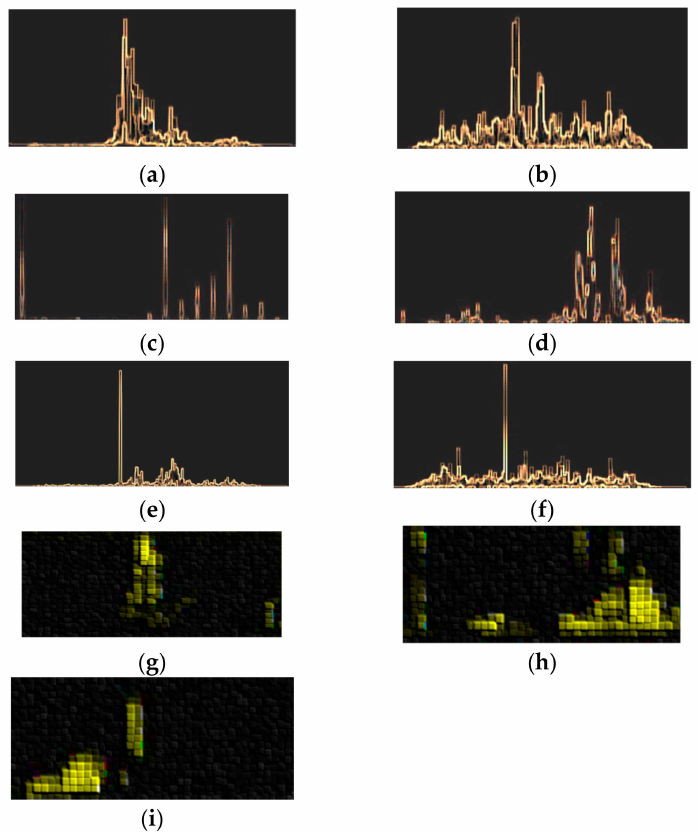
Figure 9. ( a – f ) Original image samples; ( g – i ) main characteristics of the spectrum in the three states, six in input graphs, and three hopping feature maps.